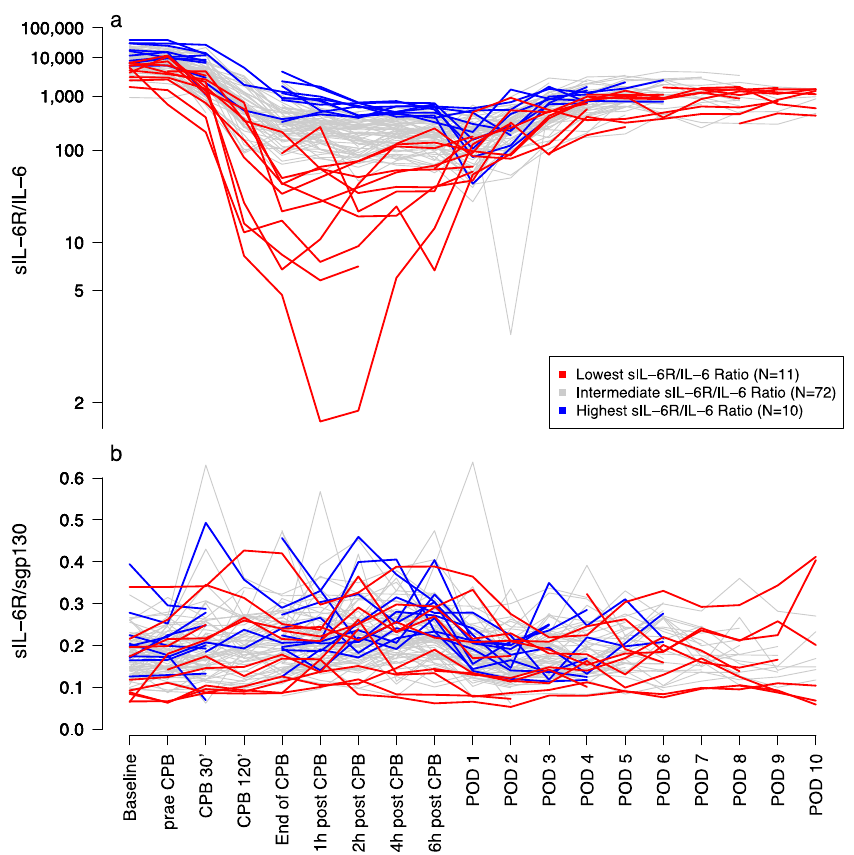
Figure 3. sIL-6/IL-6 and sIL-6R/sgp130 ratio. The lines show the perioperative levels of ( a ) sIL-6/IL-6 and ( b ) sIL-6R/sgp130 ratio at different time points. Red lines indicate patients with continuously lowest levels, blue lines indicate patients with continuously highest levels and grey lines indicate patients with intermediate levels of perioperative sIL6-R/IL-6 ratio measured between timepoint 3 and 9. Abbreviations: CPB, cardiopulmonary bypass; POD, postoperative day; sgp130, soluble glycoprotein 130; sIL-6R, soluble interleukin-6 receptor.